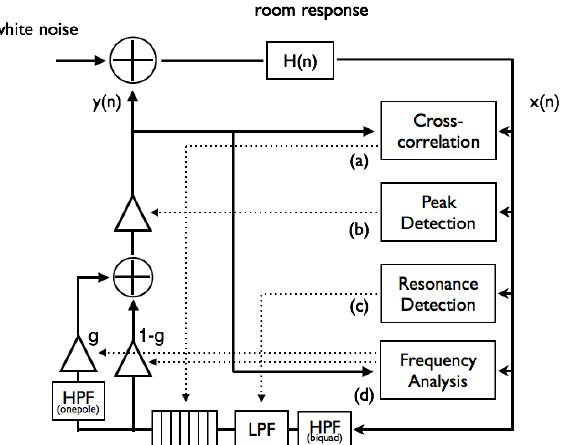
Figure 3. Overview of the system for simulating ( a ) tempo control by delay line length depending on room reverberation (Section 3.1), ( b ) volume control by gain threshold depending on volume of ambient noise (Section 3.2), ( c ) timbre control by cutoff frequency of a low-pass filter depending on a prominent resonance (Section 3.3) and ( d ) timbre control by gain of a one-pole high-pass filter according to the distribution of room modes (Section 3.4).